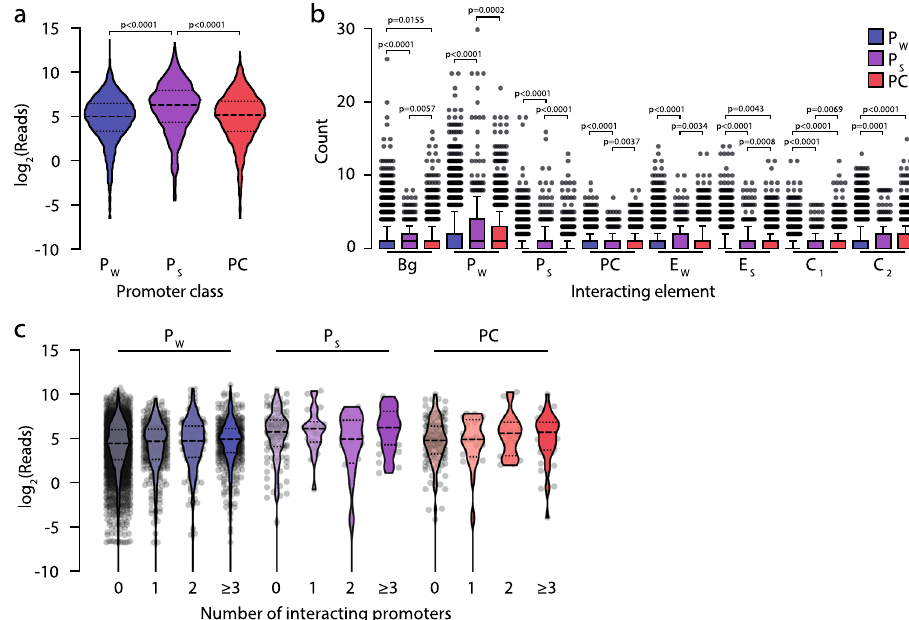
Fig. 6 Promoter-hubs do not show synergy. a 4sU-seq measured expression of genes with promoters classi fi ed by GenoSTAN as having weak H3K27ac ( P W ), strong H3K27ac ( P S ), or a CTCF (PC). b Boxplots of interacting elements for each promoter class show 10th percentile (lower whister), 25th percentile, median, 75th percentile and 90th percentile (upper whisker). For a and b , p -values are for a two-sided Kruskal – Wallis test with Dunn ’ s multiple test correction. n = 5498 P W , 403 P S , and 1905 PC promoter viewpoints. c Expression of genes that do not interact with enhancers grouped according to the number of promoters that they interact with. An equivalent analysis for genes that interact with enhancers is in Supp. Fig. 31. Source data are available in the Source Data fi